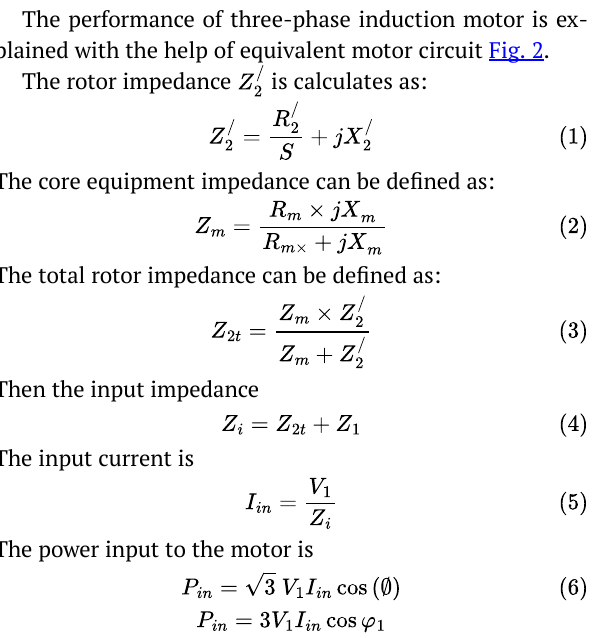
Fig. 2. Equivalent circuit of 3- induction